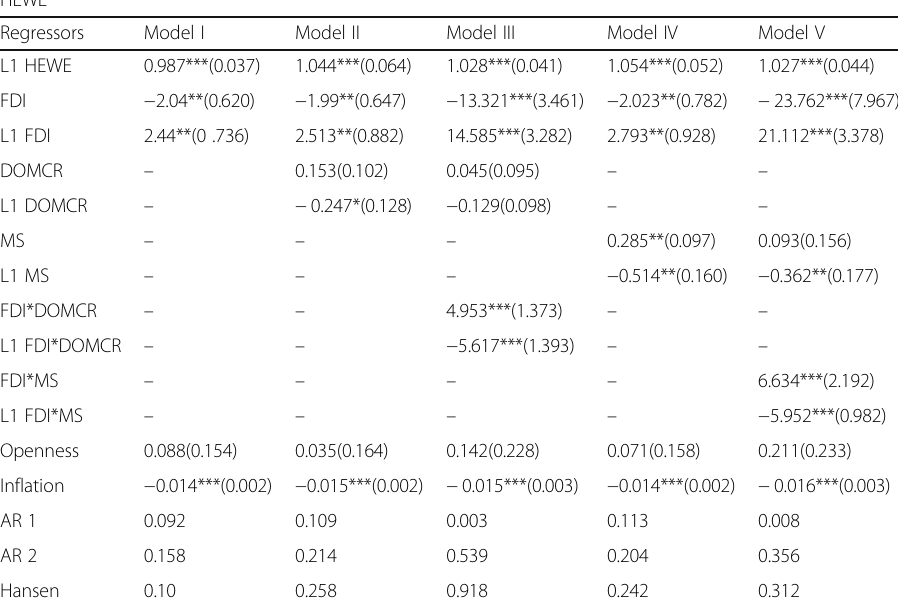
Table 2 Dynamic panel data estimation, one-step system GMM: Interaction effect of FDI and FD on HEWE